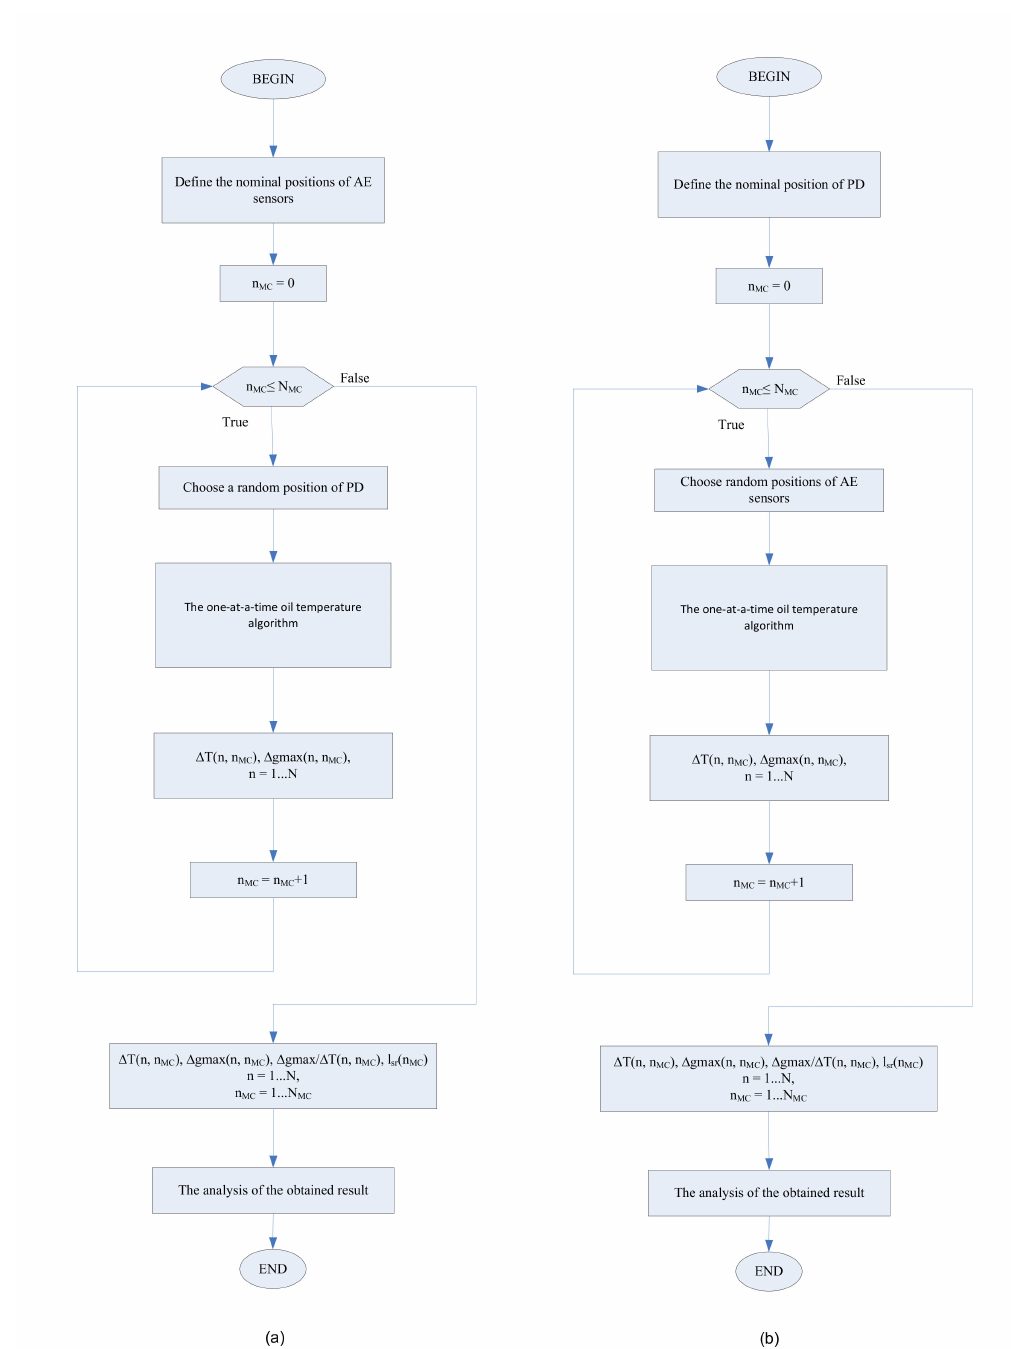
Figure 2. ( a ) First variant of the algorithm for simultaneous variations in input variables, where the positions of the acoustic emission (AE) sensors remain unchanged; ( b ) second variant of the algorithm, where the PD position remains unchanged. The current iteration number is marked with n MC